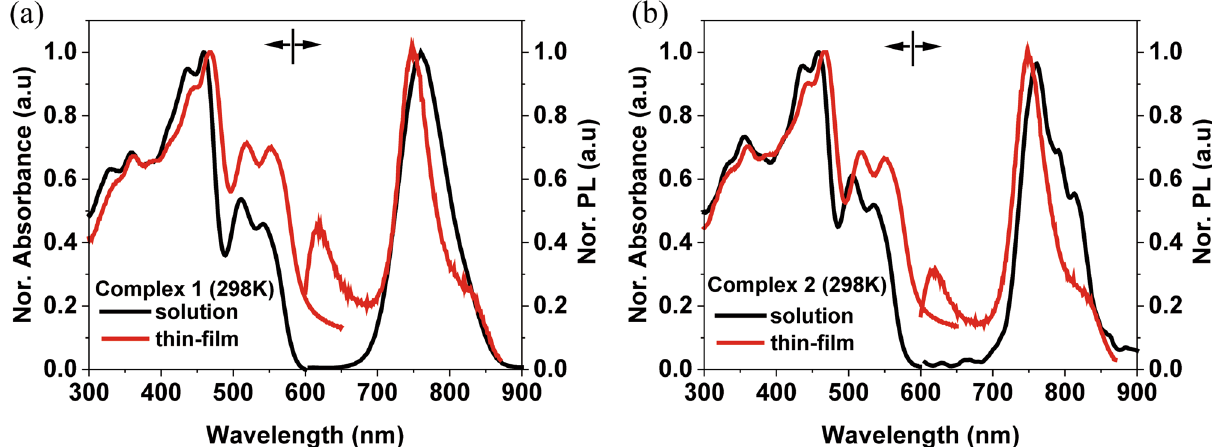
Figure 3. UV–Visible absorbance and PL in solution (black line), thin-film (red line) at room temperature (298 K): ( a ) Ir(mCPDTiq) 2 tmd and ( b ) Ir(mCPDTiq) 2